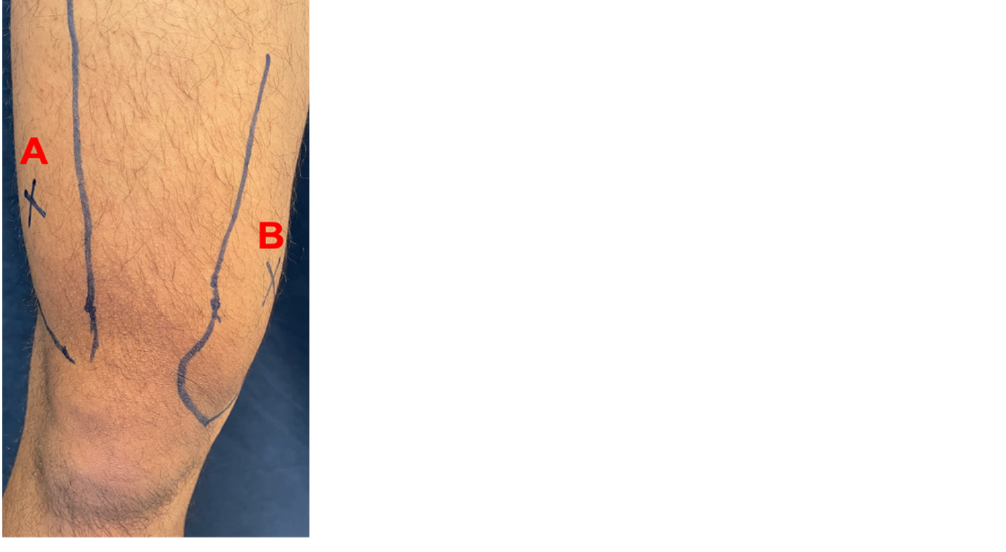
Figure 2. Measurement points in anterior thigh muscles. ( A ) vastus lateralis, ( B )vastus medialis. The photo provided by Dr. Mon-Chien Lee.